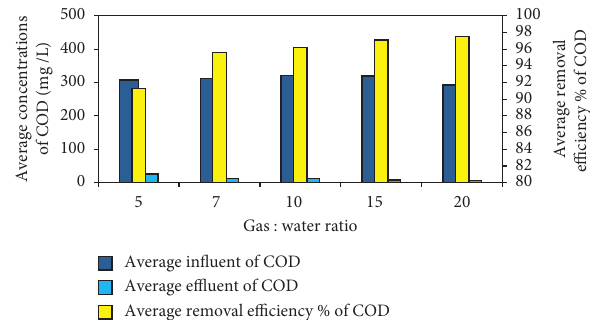
Figure 7: Effect of gas :water ratio on the average COD Figure 4: Performance of A/O MBBRs system for NH + -N re- sd � 0.11 mg/L) and by 43.65% (DO � 0.181 mg/L, with 4 moval under different gas :water ratios. sd � 0.01 mg/L), respectively. The continuous recycling of − from the aerobic zone to the anoxic zone led to in- NO 3 crease in the DO concentration in the anoxic MBBR, so the The average concentrations of DO in A/O MBBRs under gas : water ratio increased, and the DO in anoxic MBBR different gas : water ratios are shown in Figure 2. During the increased until exceeding the permissible limit (0.5 mg/L) first continuous-flow operation mode and when the gas : and reached 0.65 mg/L (sd � 0.08 mg/L) when the gas : water water ratio equaled 5 :1, the average DO concentrations in ratio became 10 :1. At gas : water ratio of 10 :1,15 :1, and 20 : both aerobic MBBR and anoxic MBBR were 2.43 mg/L 1, the A/O MBBRs treatment system became similar to the (standard deviation (sd) � 0.17 mg/L) and 0.126 mg/L (sd � 0.03 mg/L), respectively. When the gas : water ratio increased to 7 :1, the average DO concentrations in both A/ O MBBRs increased by 62.96% (DO � 3.96 mg/L, with